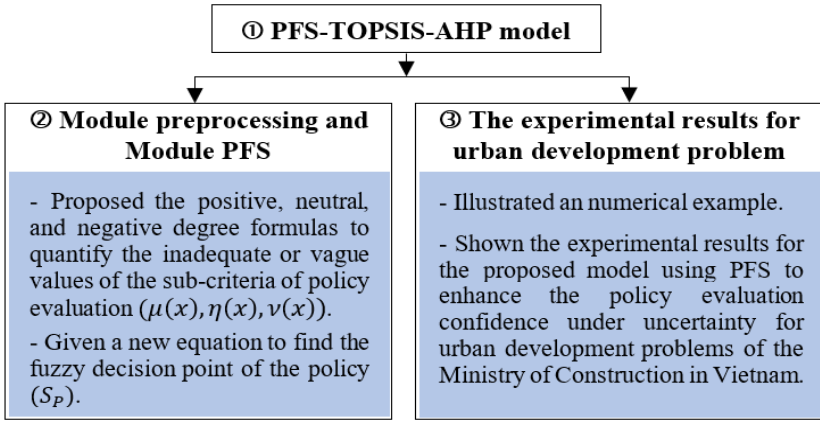
Figure 1. The key contributions of the